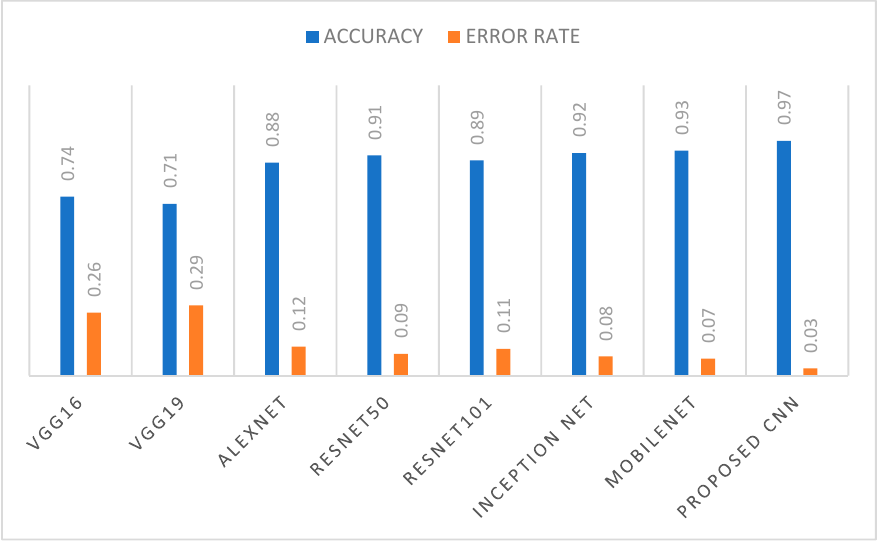
Figure 6. Comparison analysis of all the models using accuracy and error rate. Table 5. Various performance measures of different models.